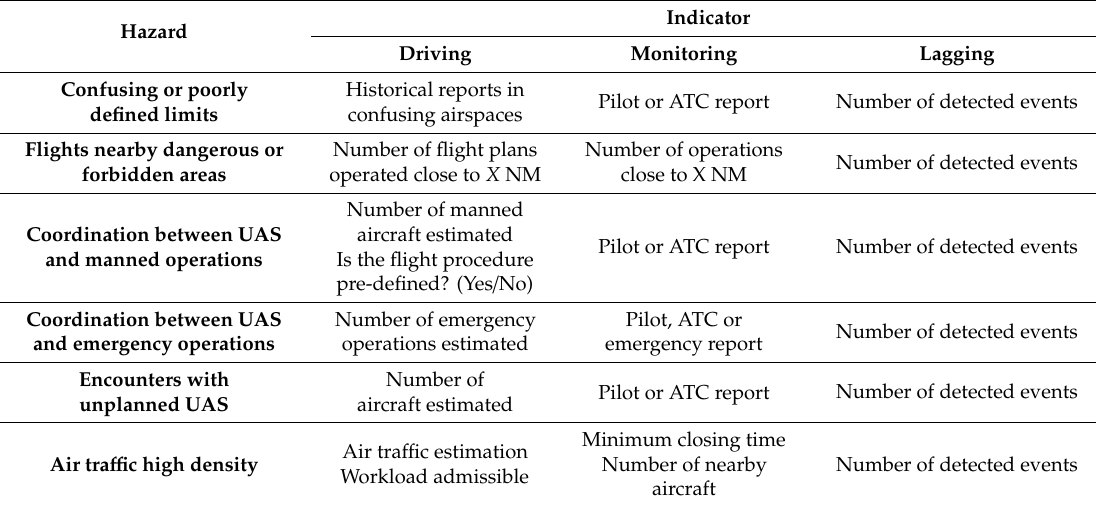
Table 6. Safety indicators regarding airspace usage and